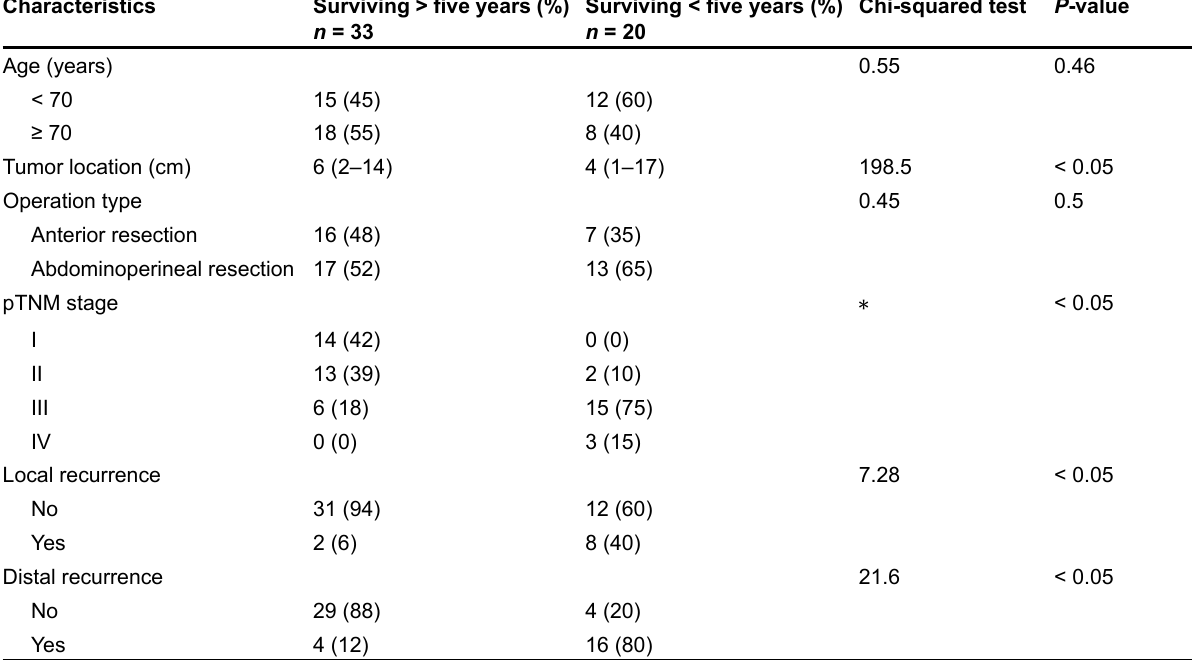
Table 1. Clinical and pathological characteristics of included rectal cancer patients ( continued ) Characteristics